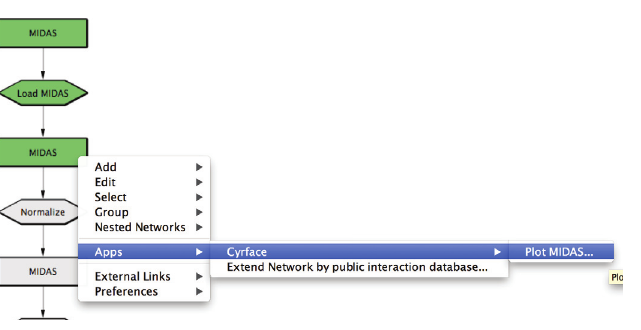
Right-click on the respective MIDAS node and the selecting the Cyrface -> Plot MIDAS … option will pop-up a plot of the